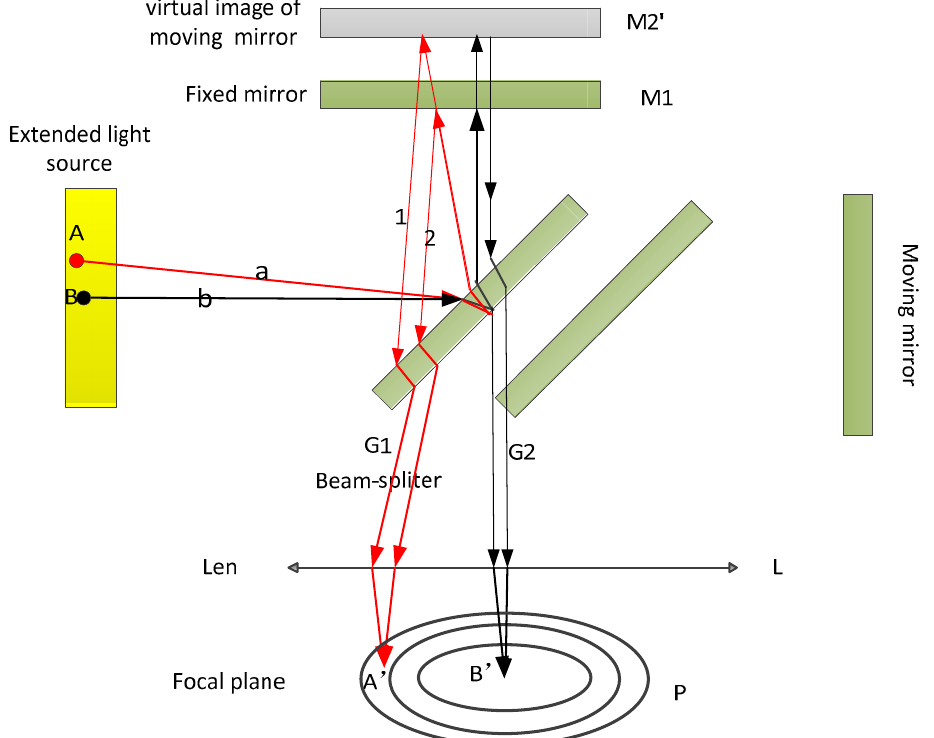
Figure 2. Off-axis light in the Michelson interferometer. The light wave passes through the mirror and lens, and arrives at the focal plane. Light sources A and B represent the different positions of the extended light source.